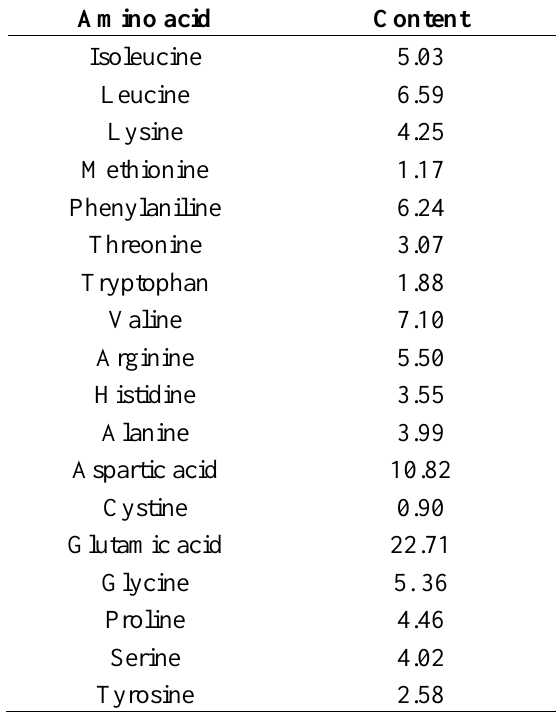
Table 3. Percent composition of amino acids in I. hederacea seeds.